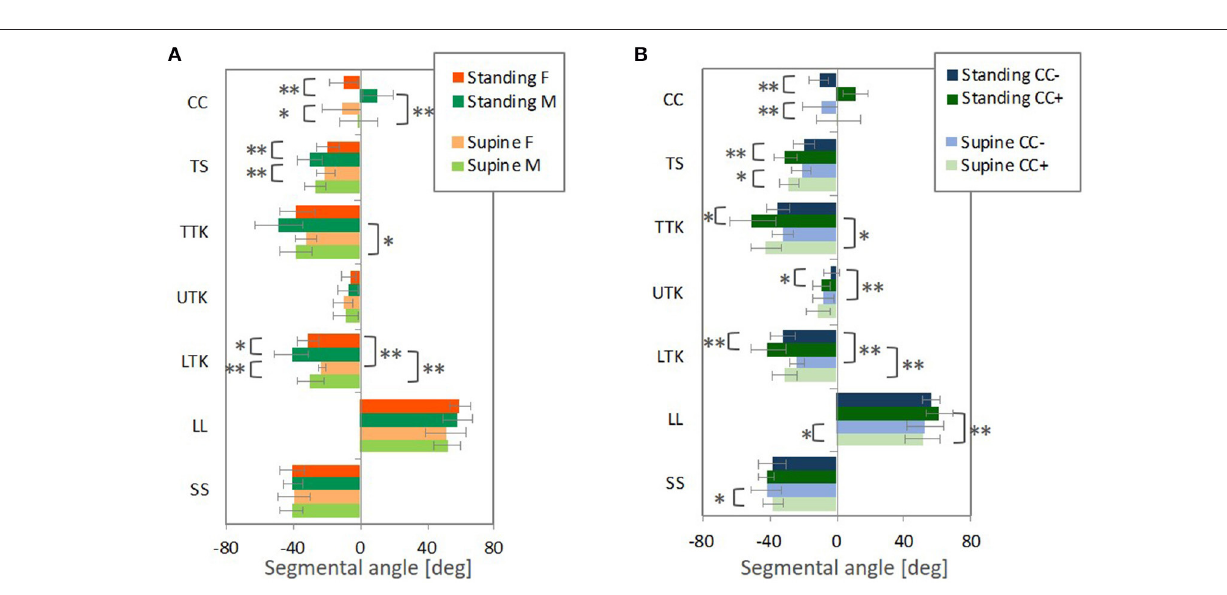
FIGURE 11 | The average segmental angles with standard deviation and p -value from t -test (** < 0.05, * < 0.1), (A) comparing male and female subjects (M and F) and (B) the negative CC (CC − ) and positive CC (CC +